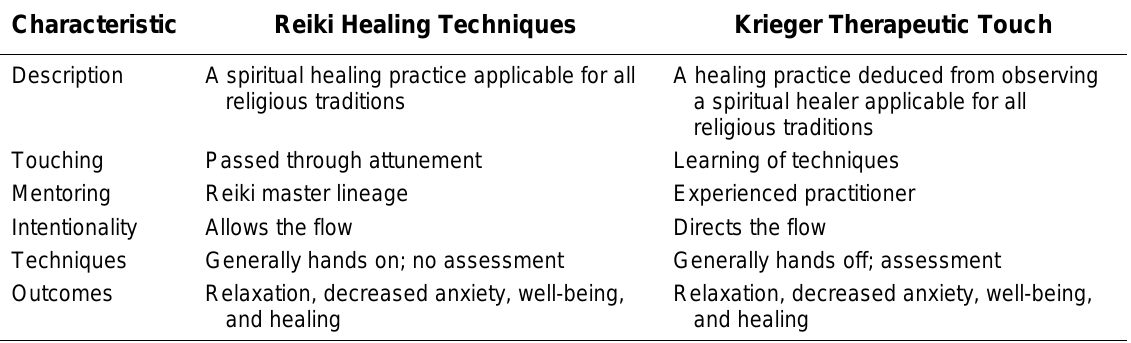
Distinctions between Reiki’s and Therapeutic